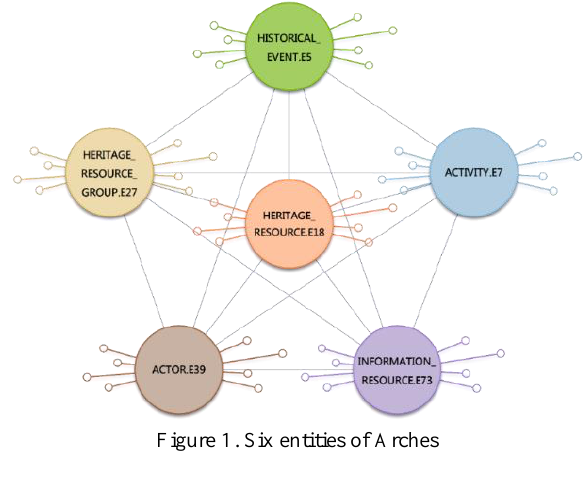
Figure 1. Six entities of